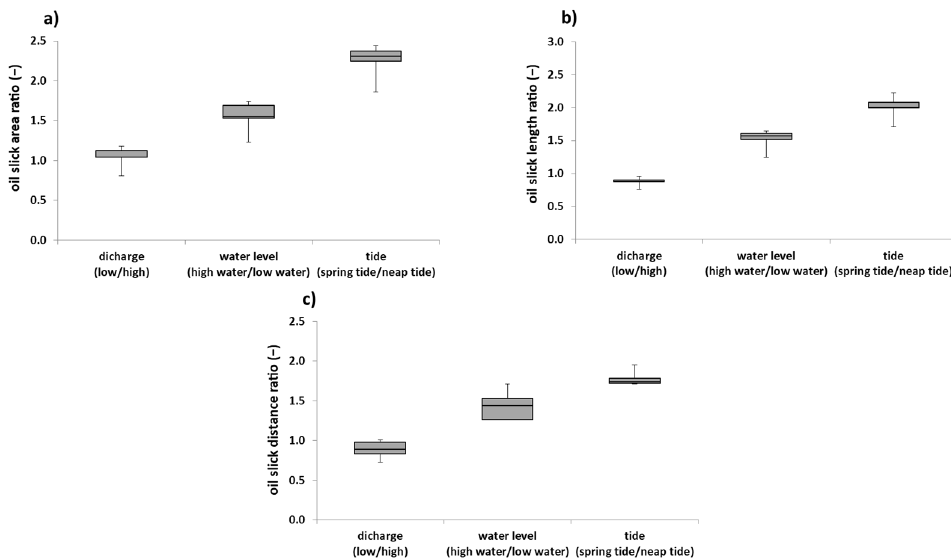
Figure 5. Boxplots of relative influences of hydrodynamic properties on: ( a ) oil slick area; ( b ) oil slick length; and ( c ) oil slick distance, for spills released at L2.